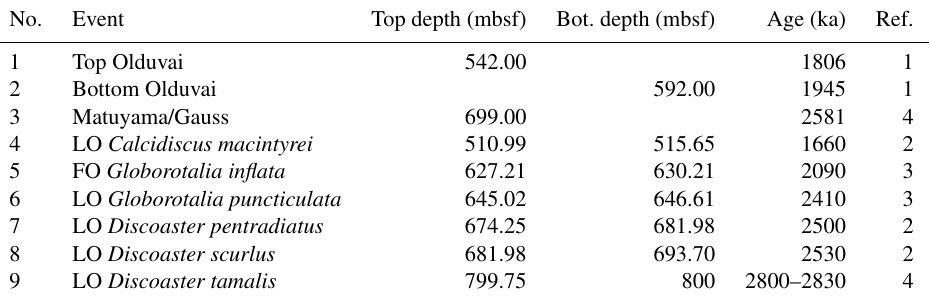
Table 1. Palaeomagnetic and biostratigraphic tie points used in the primary age model of Site U1389 based on shipboard data following Hernández-Molina et al. (2013) and Stow et al. (2013). 1: Gradstein et al. (2012); 2: Raffi et al. (2006); 3: Lourens et al. (2004); 4: (Grunert et al., 2017).